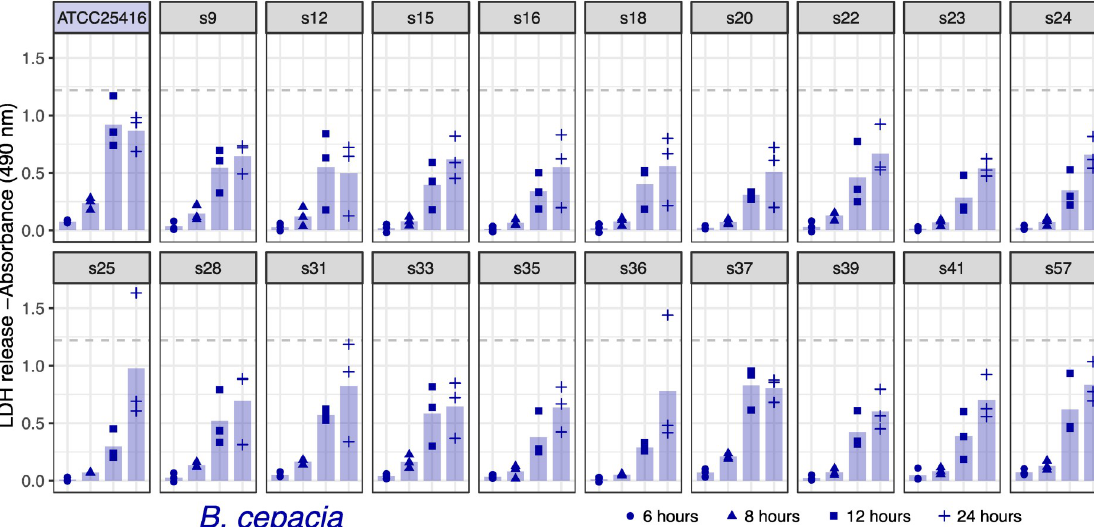
Fig 4. B . cepacia lactase dehydrogenase (LDH) release from macrophage. 6, 8, 12, and 24 hours post exposure to B . cepacia along with terrestrial reference strain ATCC25416. Increased absorbance correlates to increased LDH release from macrophage. Horizontal dotted grey line indicates “TritonX” complete lysis. As compared to the reference strain via two-sided t-tests, none were found to have an adjusted p- value < 0.61 (adjusted by Bonferroni correction). Bars depict means, all points are plotted (n = 3).